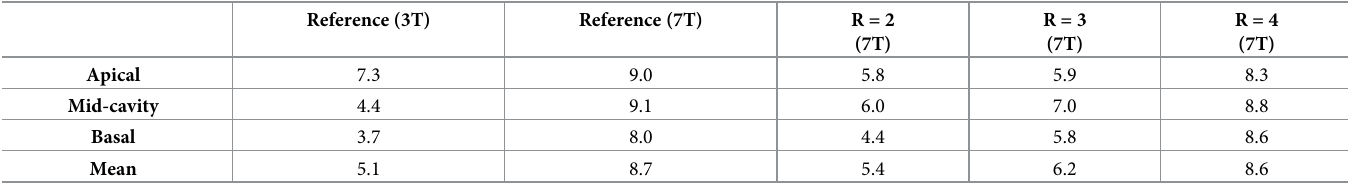
Table 1. Helix angle standard deviation within apical, mid-cavity and basal parts of the left ventricle.